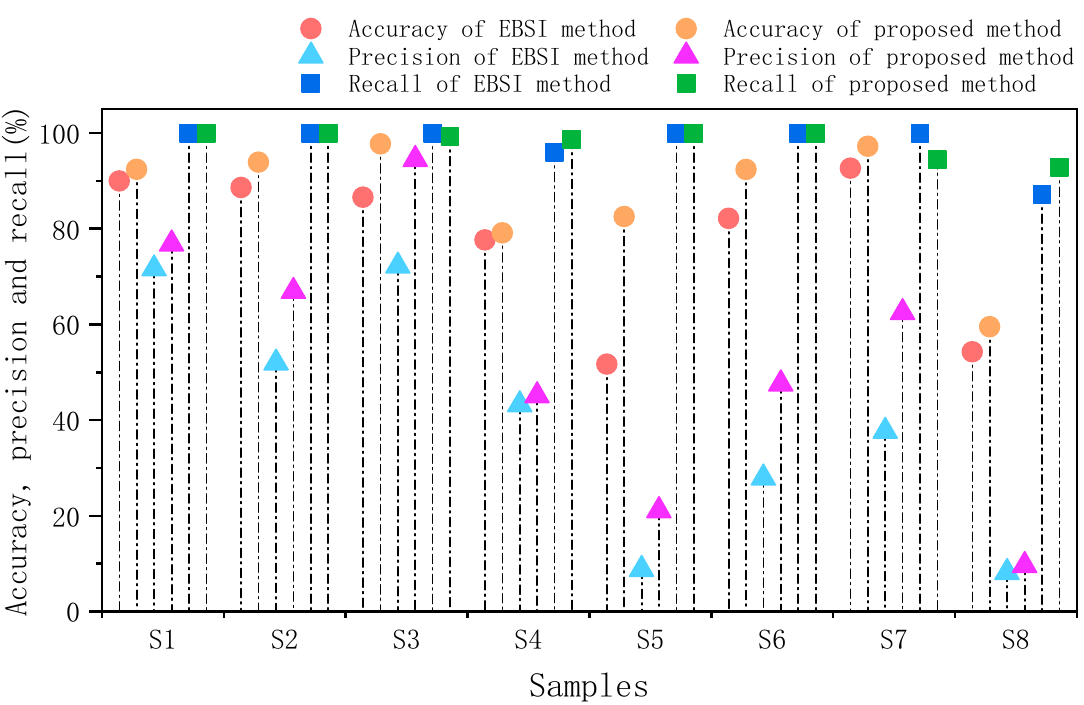
Figure 14. Comparative data of accuracy, precision, and recall for all samples.